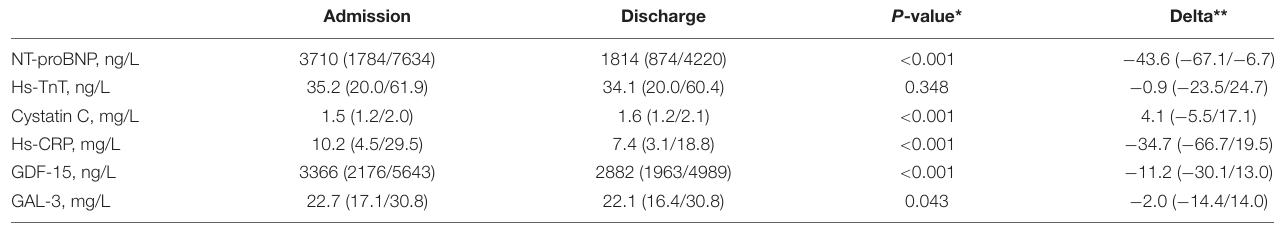
TABLE 2 | Time course of biomarkers during the clinical compensation of acute HF.